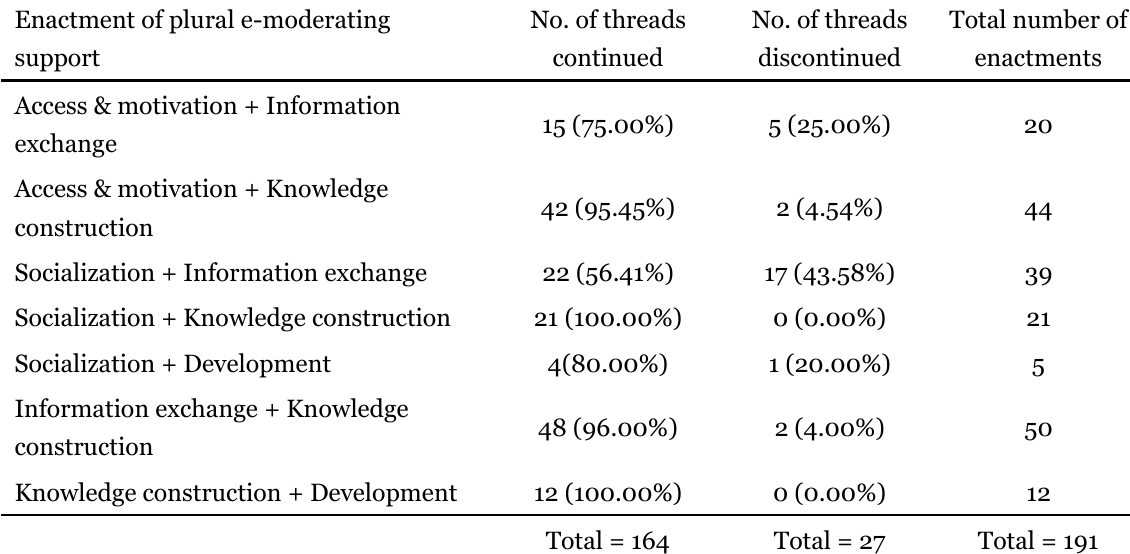
Effect of Plural E-Moderating Supports on Thread Termination and Development Enactment of plural